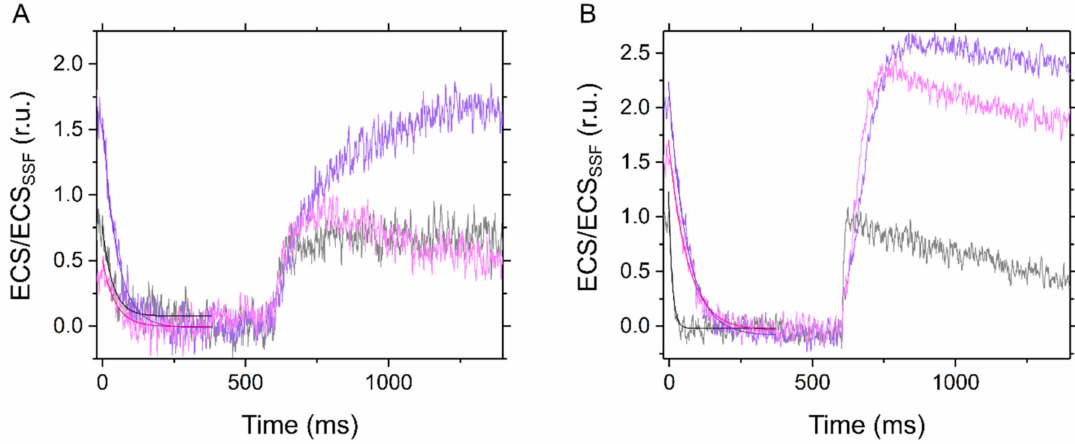
Figure 3. Dark-interval relaxation kinetics of electrochromic shift (ECS) in the C 3 plant mustard ( A ) and the C 4 plant maize ( B ) under ambient air (40 Pa CO 2 , 21 kPa O 2 ; black), low CO 2 (1 Pa CO 2 , 21 kPa O 2 ; purple), and low CO 2 /O 2 (1 Pa CO 2 , 1 kPa O 2 ; pink). Red actinic light (550 µ mol photons m − 2 s − 1 ) was turned off at 0 ms for 600 ms during the steady-state photosynthesis. The ECS values were normalized by the ECS amplitude induced by 5 µ s short saturation flash (ECS SSF ). The kinetics were fit to mono exponential decay ( R 2 , coefficient of determination: 0.7017, 0.9454, and 0.6868 in A; 0.8814, 9868, and 0.9801 in B,